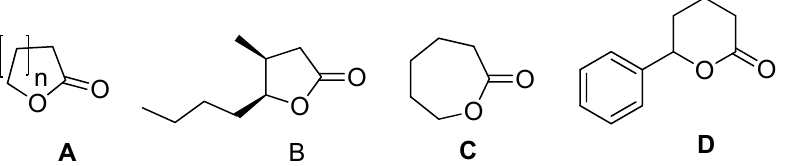
Figure 1. Representative examples of lactone structure: lactone ( A ), whiskey lactone ( B ), ε -Caprolactone ( C ), and 6-phenyl tetrahydro pyran-2-one ( D